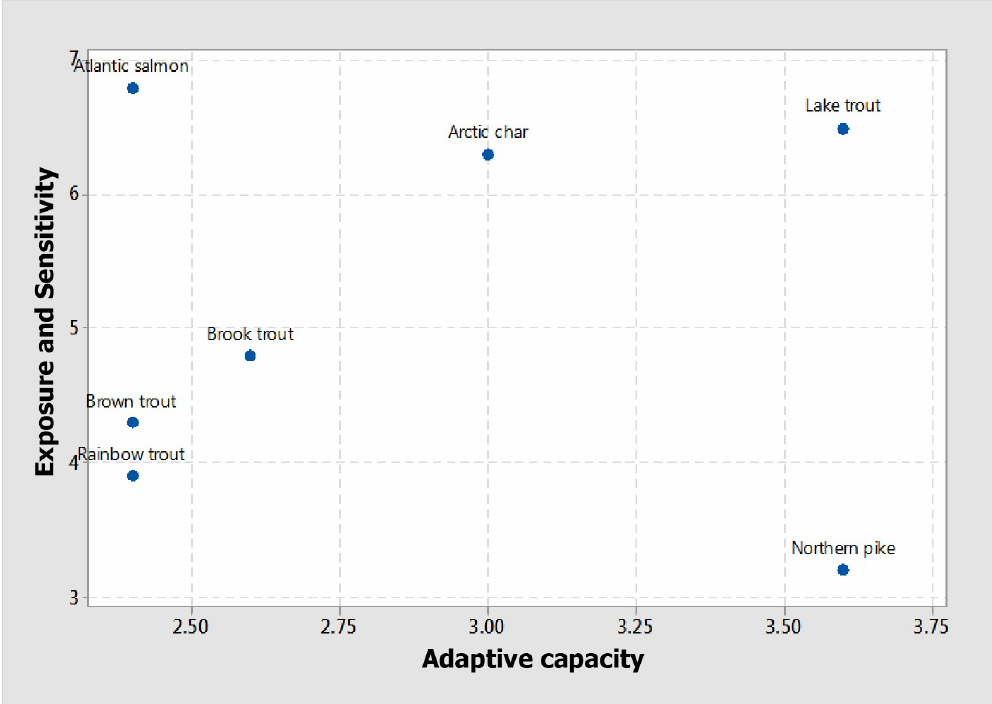
Fig 2. Scatterplot showing the relationship between exposure/sensitivity and adaptive capacity for the selected